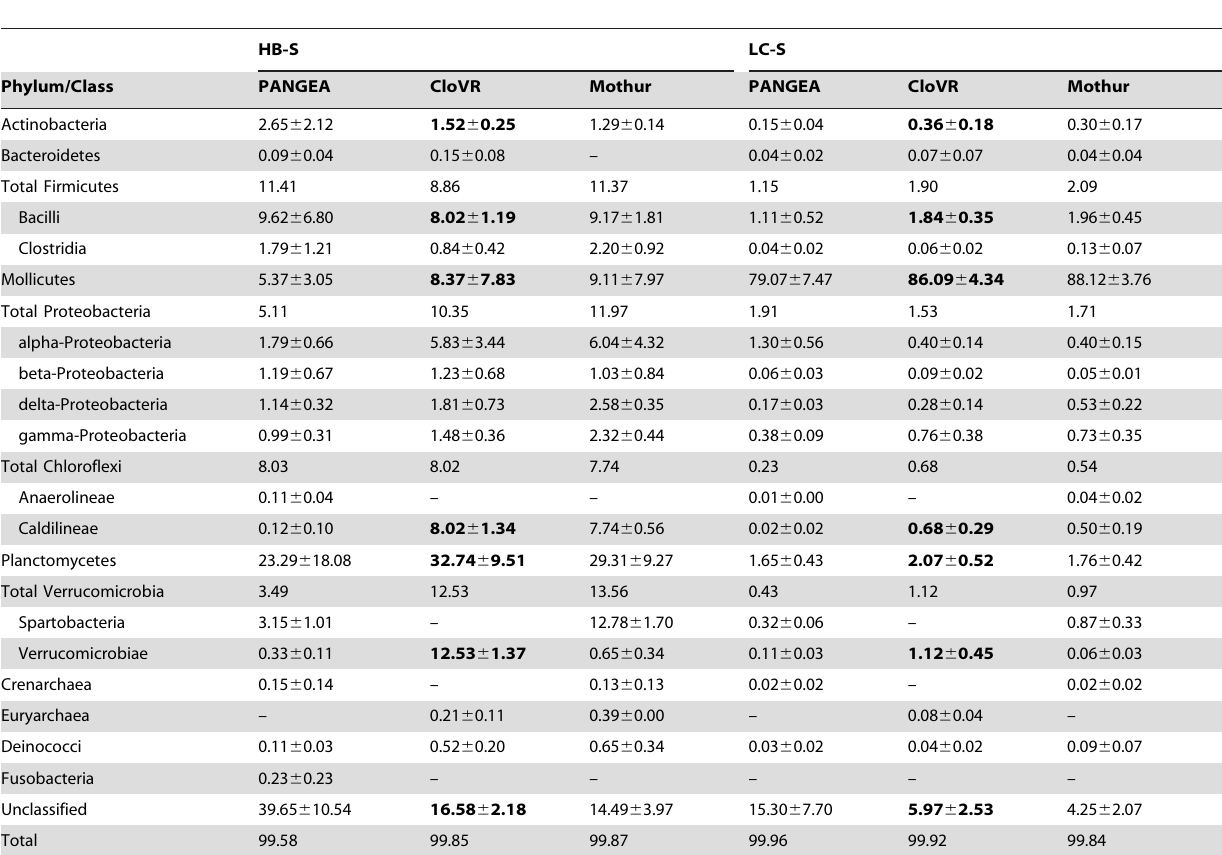
Table 1. Stomach microbiome compositions of C. virginica from Hackberry Bay and Lake Caillou, Louisiana determined by three